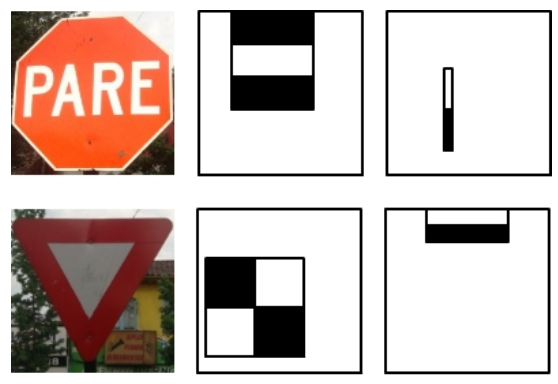
Figure A1. First and second Haar-like convolution masks for stop and yield signs employed in this